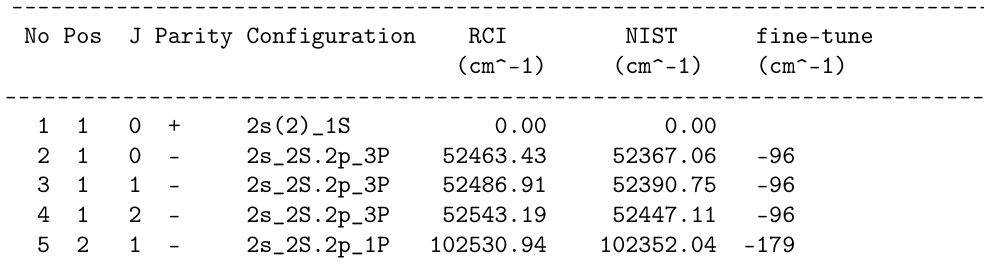
Table 1. Excitation energies from rci_mpi calculations compared with experimental energies from the NIST database. The differences give how much the energies of the odd states should be fine-tuned to be in accordance with the experimental